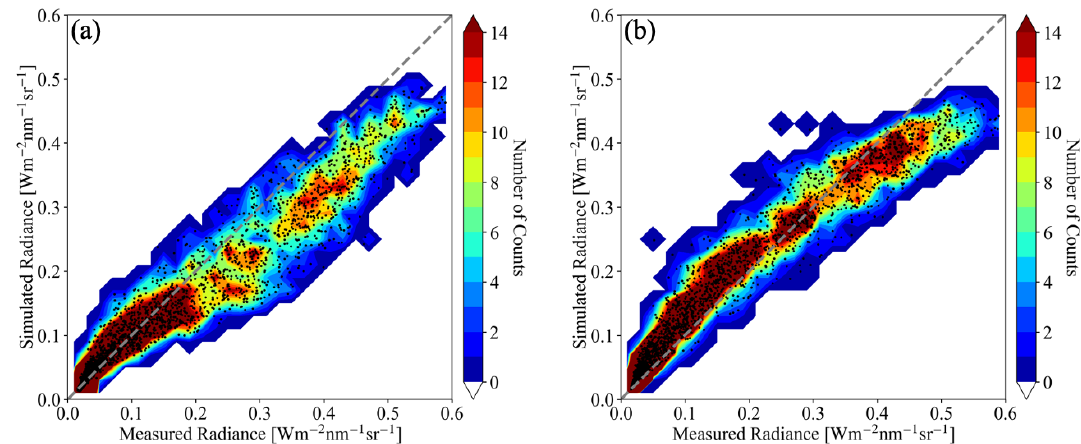
Figure 13. Scatter plot superimposed over a 2D histogram of 3D radiance calculations at 600nm based on cloud optical thickness (a) esti- mated by IPA and (b) predicted by the CNN versus measured red-channel radiance from all-sky camera.